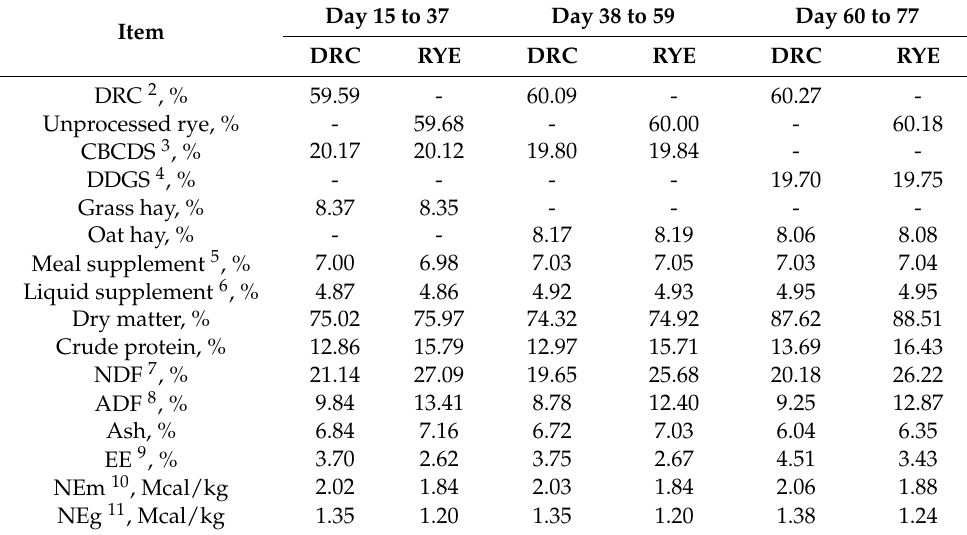
Table 1. Actual diet formulation and composition based upon weekly DM determinations and monthly ingredient composite nutrient compositions 1